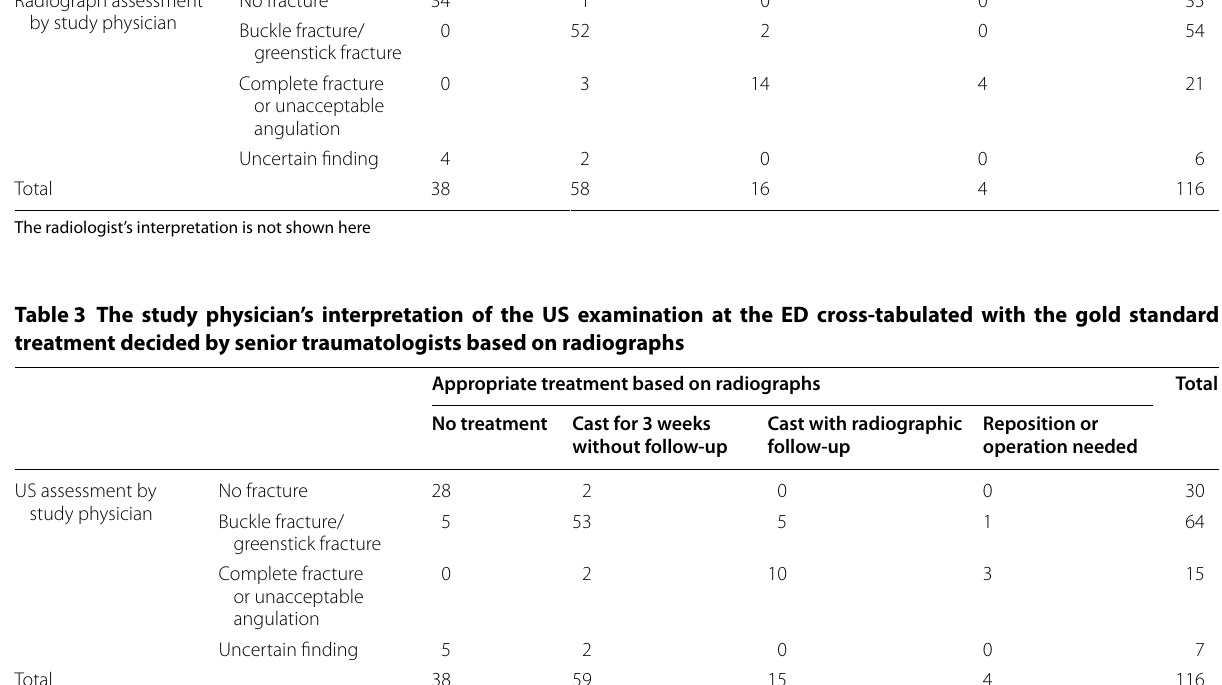
Table 2 The study physician’s interpretation of the radiographs at the ED cross-tabulated with the gold standard treat- ment decided by senior traumatologists based on radiographs